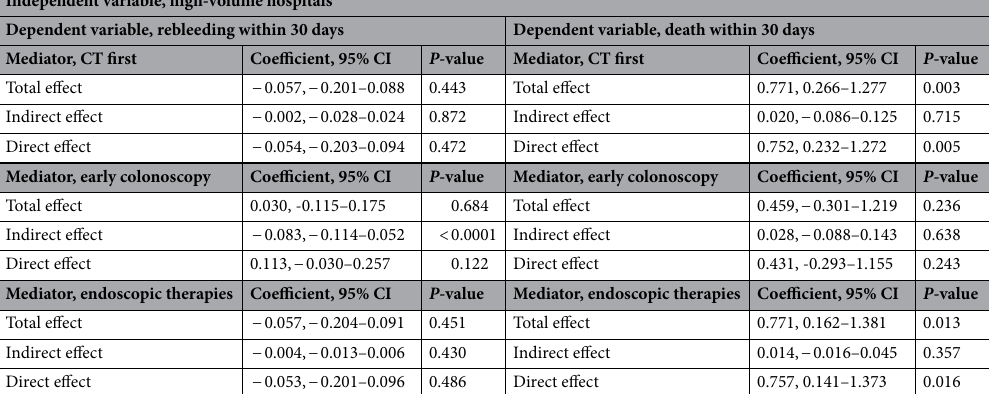
Table 6. Mediation analysis between hospital characteristics and rebleeding and death within 30 days in the matched cohort. Computed tomography used as a first-line diagnostic modality, early colonoscopy, and endoscopic therapies were included in the mediation analysis as the mediators. A two-tailed P -value < 0.05 was considered to indicate statistical significance. CT computed tomography, CI confidence